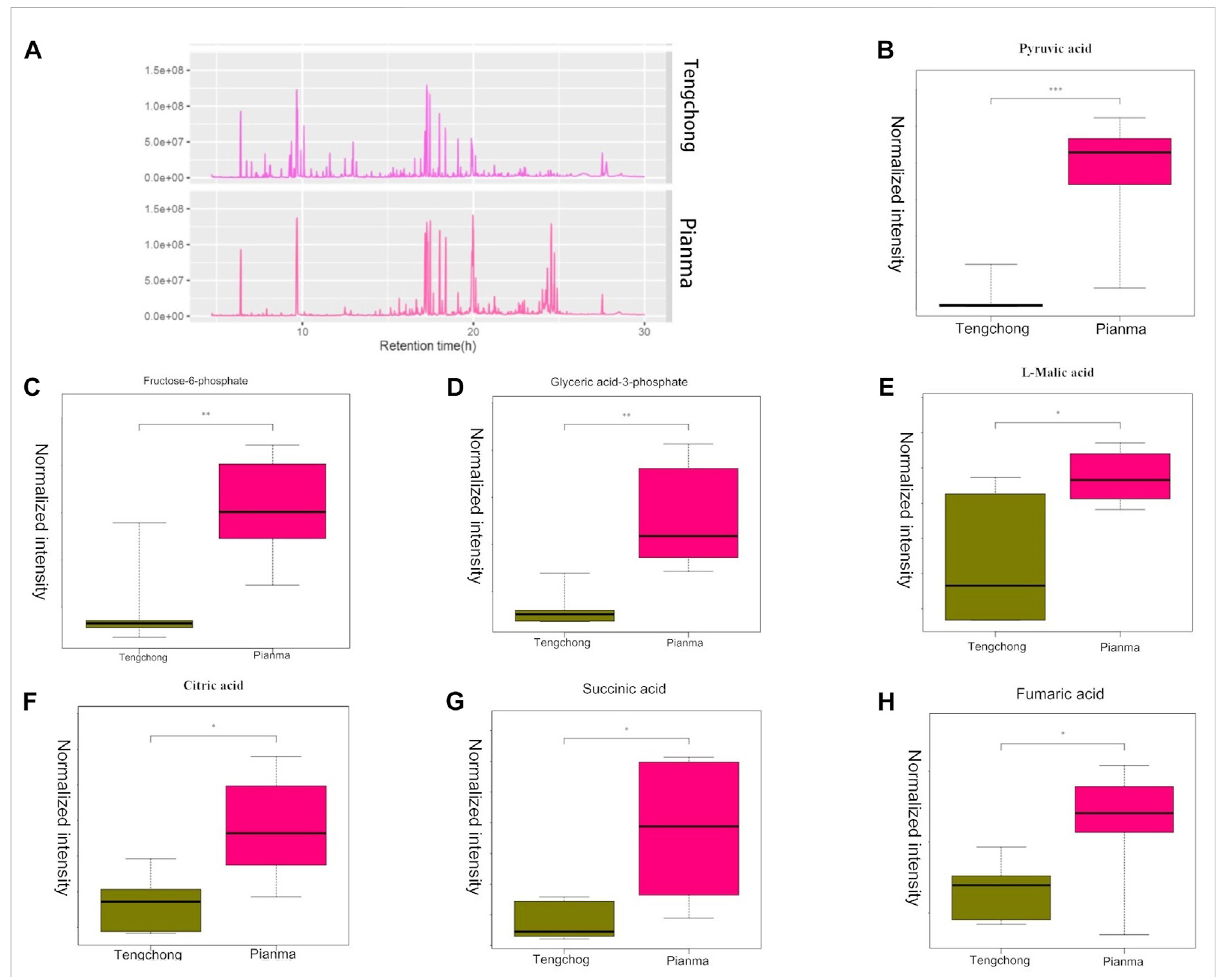
FIGURE 2 Changes of the total ion fl ow diagram (A) , pyruvate (B) , fructose 6-phosphate (C) , glyceryl 3-phosphate (D) , L -malic acid (E) , citric acid (F) , succinic acid (G) , and fumaric acid (H) in Tupaia belangeri between TC and PM *: p < 0.05; **: p <